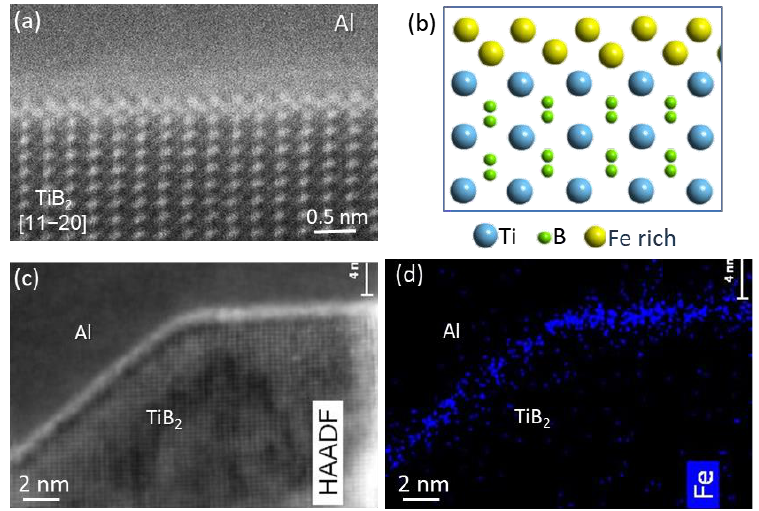
Figure 20. Fe segregation at the Al/(1 1 0 0)TiB 2 (AlB 2 ) interface [64 – 66]. ( a ) High resolution STEM HAADF image showing the extra atomic layers at the interface when viewed from [1 1 2̅ 0]TiB 2 direction; ( b ) schematic showing the zig-zag atomic arrangement of the interfacial layers viewed along the direction; and ( c ) STEM HAADF image and ( d ) superX-EDS mapping confirming the enrichment of Fe at the interface.